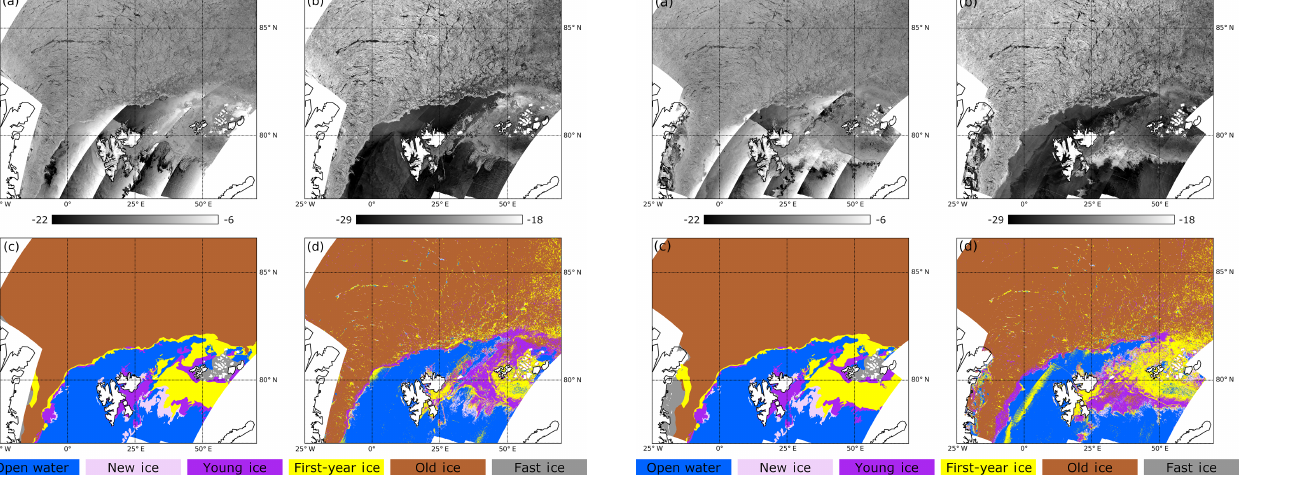
Figure 7. The 1d mosaics of Sentinel-1A/1B images ( a : HH; b : HV) and the ice classification result (d) on 5 February 2019. The publication date of the reference weekly ice chart (c) is 8 Febru- ary 2019.